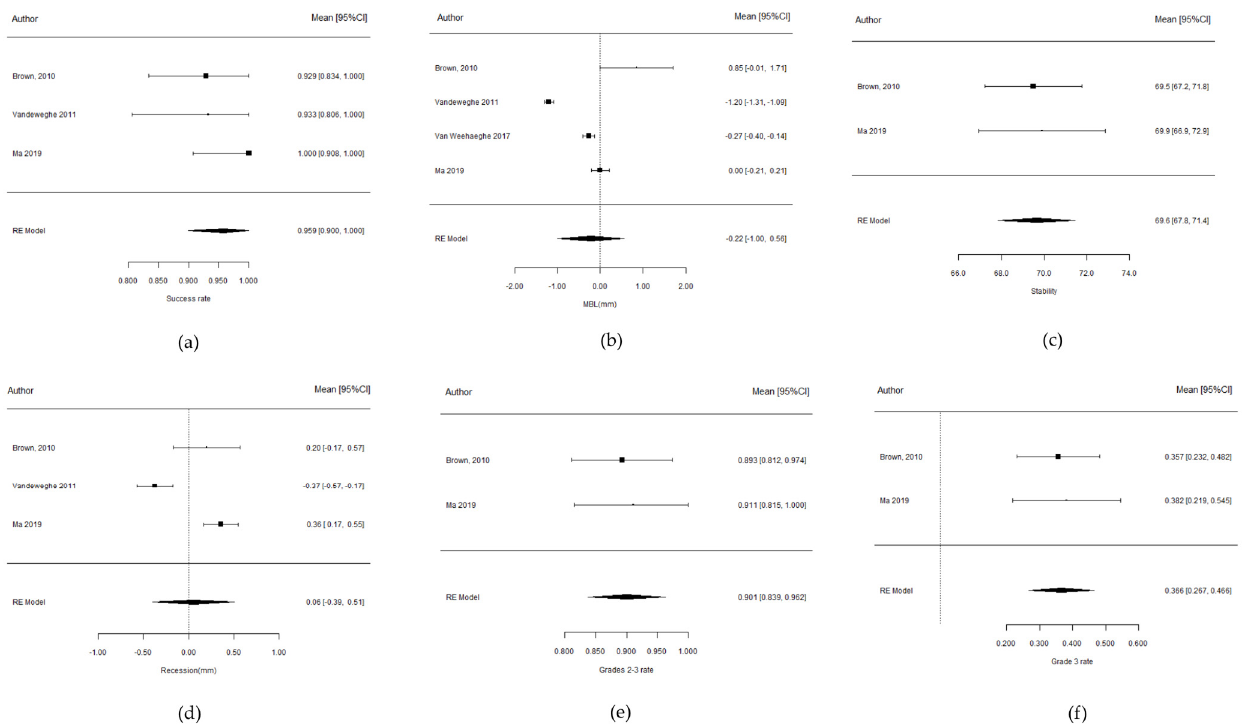
Figure 3. Forest plot showing the meta-analysis results referring to ( a ) success rate; ( b ) marginal bone level changes; ( c ) implant stability; ( d ) soft tissue recession; ( e ) papilla index grade 2–3; ( f ) papilla index grade 3 of Brown et al., 2010 [14], Ma et al., 2019 [16] and Vandeweghe et al., 2011 [18].